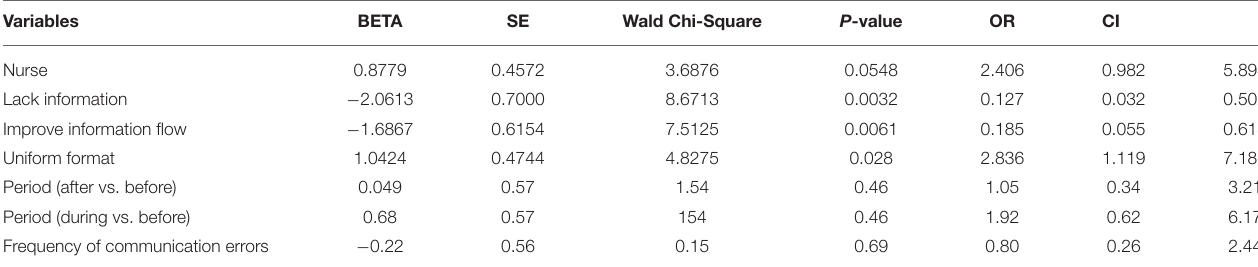
TABLE 4 | Logistic regression model predicting satisfaction using the